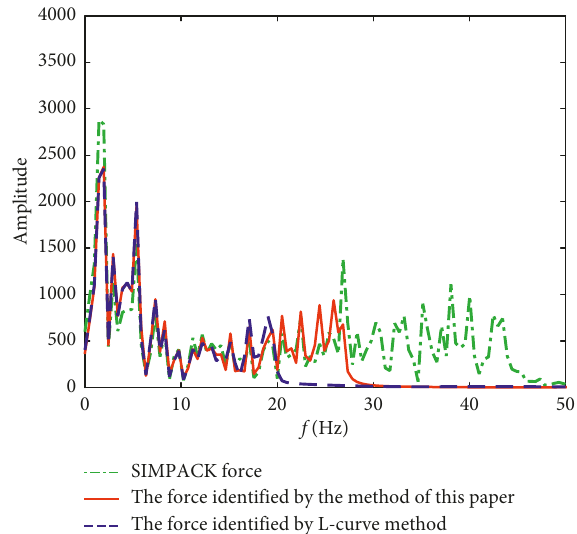
Figure 23: Amplitude-frequency curve of the two methods for F identification when the noise level is 5%. 2